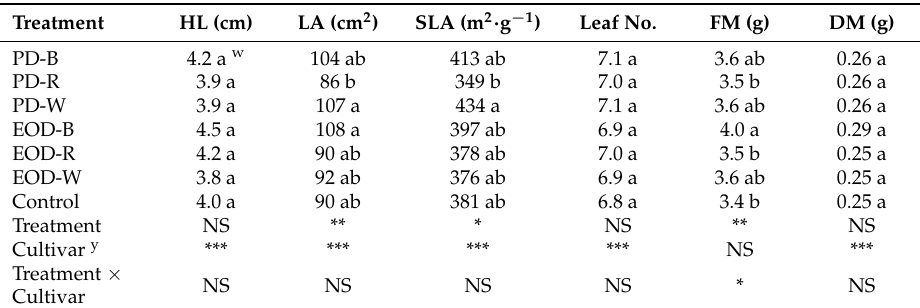
Table 1. Hypocotyl length (HL), leaf area (LA), specific leaf area (SLA), leaf number, shoot fresh mass (FM), and shoot dry mass (DM) of lettuce plants grown in a controlled environment under one of seven light treatments z